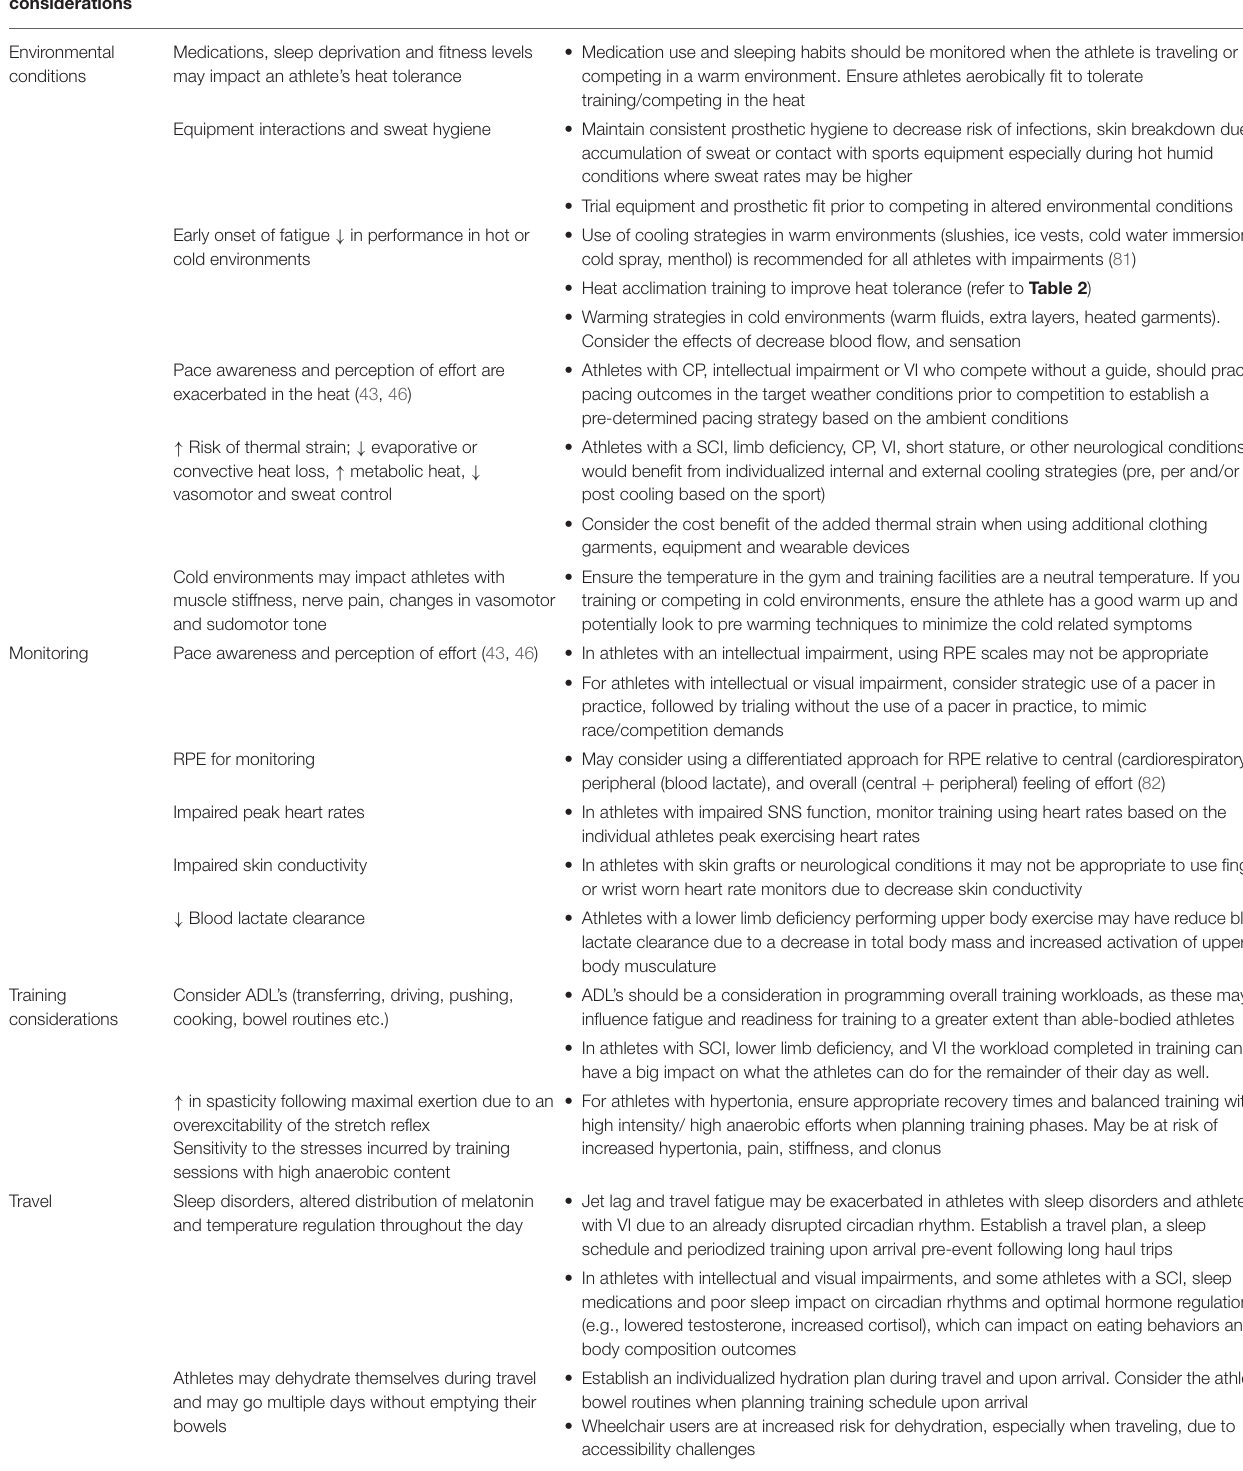
TABLE 3 | Practical and special considerations for supporting para-athletes.